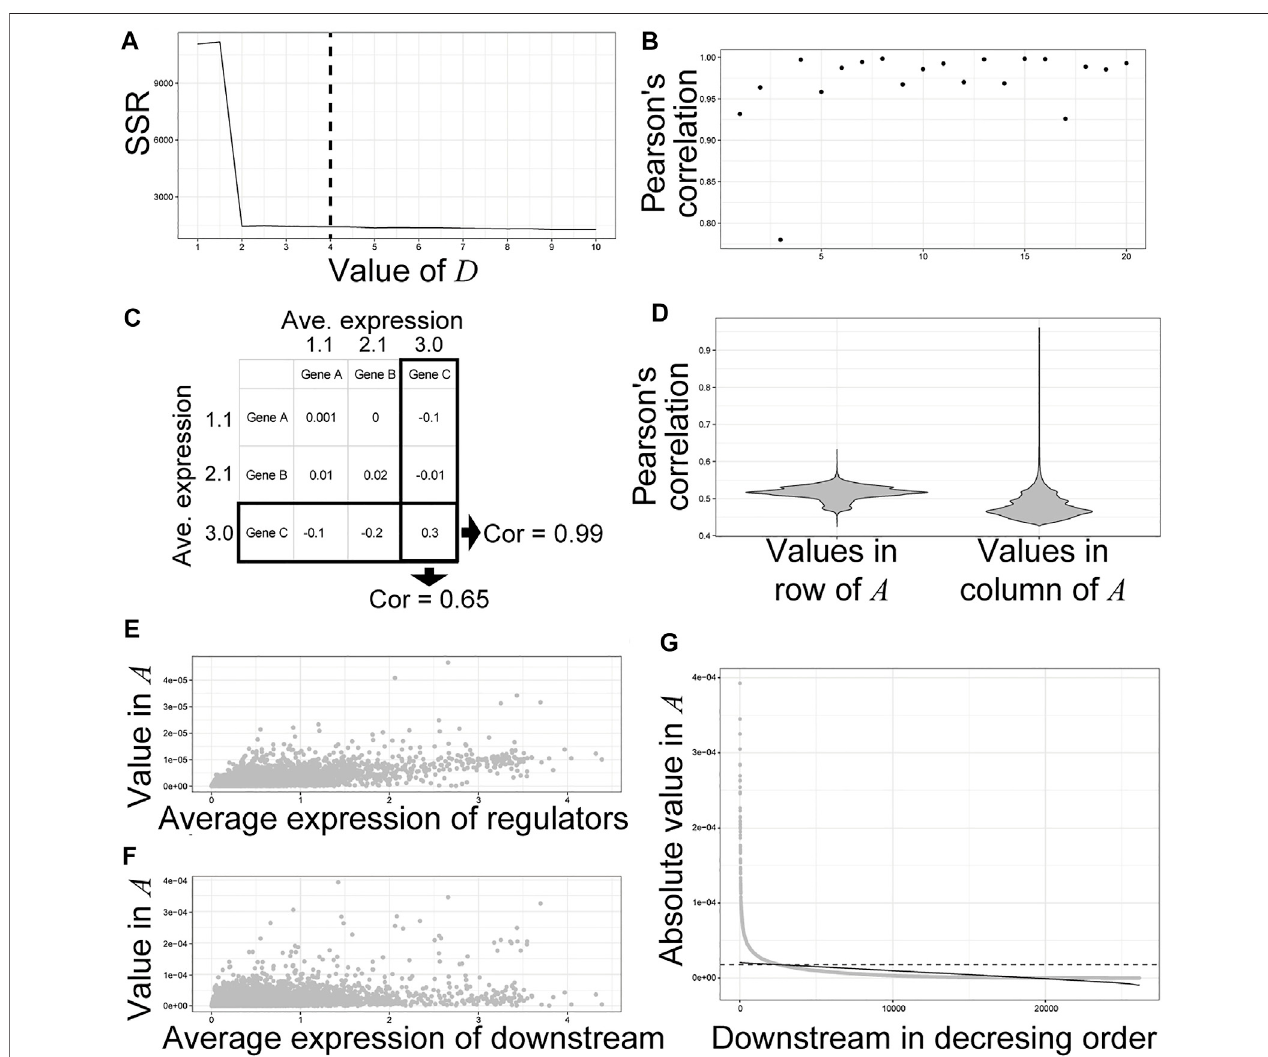
FIGURE2| Inferenceofdownstreamgenesbasedonthevaluesin (A) . (A) SelectionofaparameterDforSCODE.Thesumofsquaredresiduals(SSRs) foreach D (from 1to 10 by 0.5) was calculated. We used D (cid:2) 4. (B) Pearson ’ s correlation coef fi cients between the values ofeach A from 20 optimizations and the meanA, which is the average of each value from all optimizations. (C) Calculation of Pearson ’ s correlations between the average expression level of each gene and the absolute values in each row and column of A. (D) The violin plots of Pearson ’ s correlations. (E,F) Scatter plot of the average expression level of each gene and the absolute values in the column (E) and row (F) of A for Sox8. (G) An example of the de fi nition of thresholds for signi fi cant regulatory relationship between the regulator and downstream genes. A scatter plot of the values of A for a regulator, Sox8, in decreasing order. The solid line indicates a regression for the scatter plot. The dashed lines indicate the de fi ned